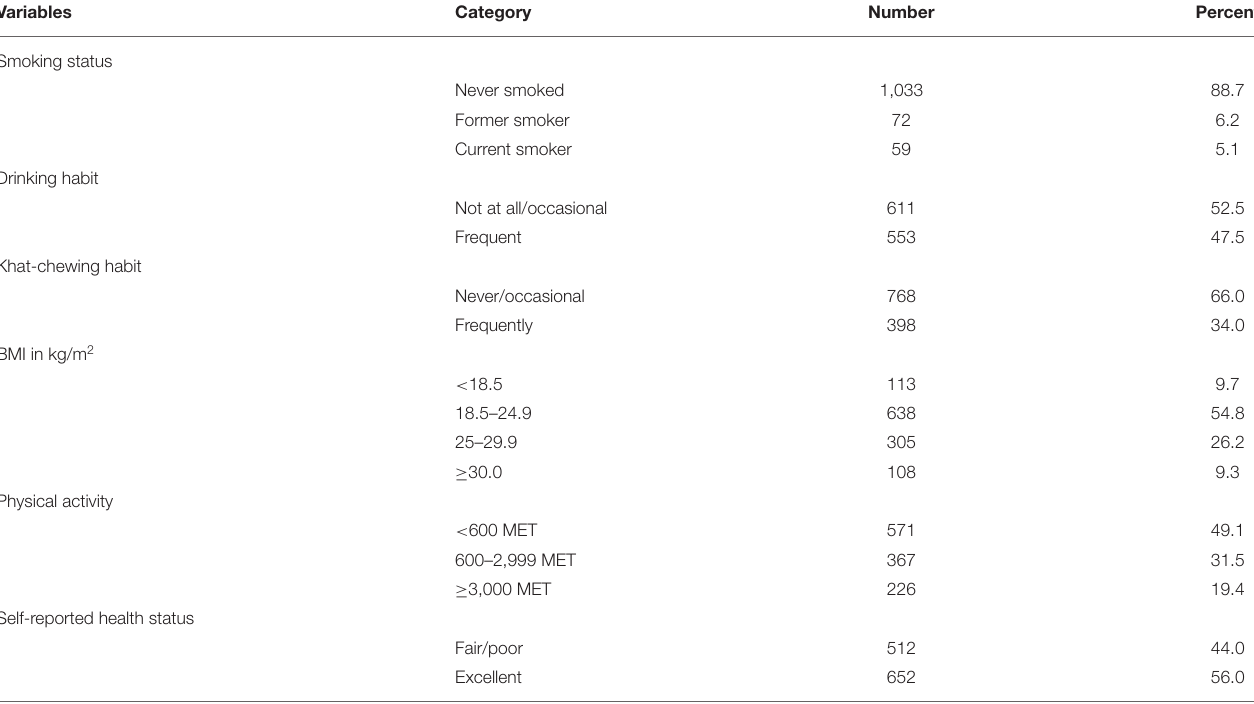
TABLE 2 | Lifestyle and health related characteristics of study participants in Eastern Ethiopia, 2019 ( n = 1,164).